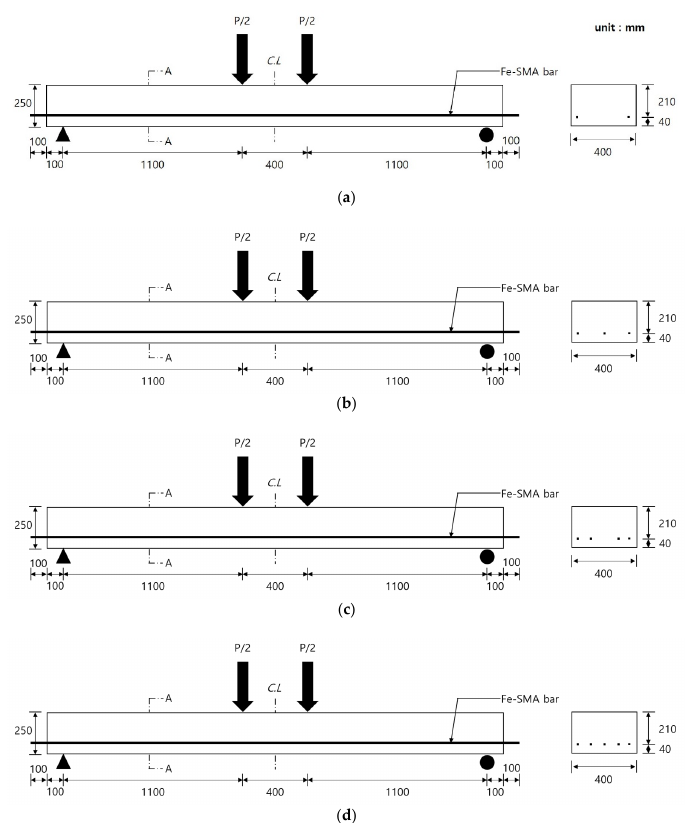
Figure 1. Details of the test specimens: (a) SL-2N and SL-2A, (b) SL-3N, SL-3A, and SL-3R, (c) SL- 4N and SL-4A, and (d) SL-5N and SL-5A.